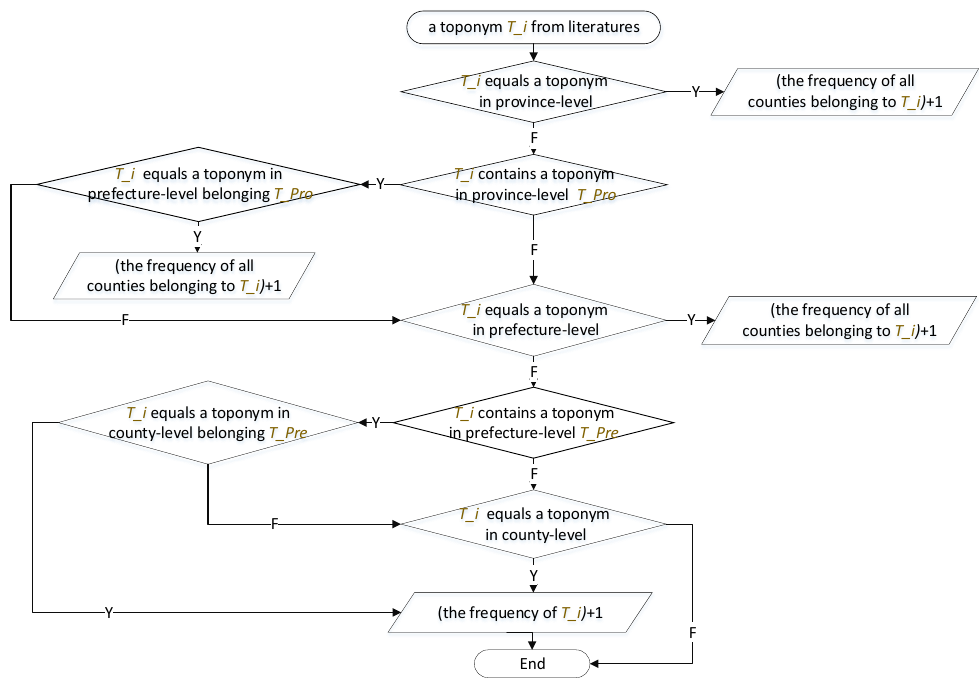
Figure 2. The Flowchart of the Chinese Toponym Matching Algorithm.